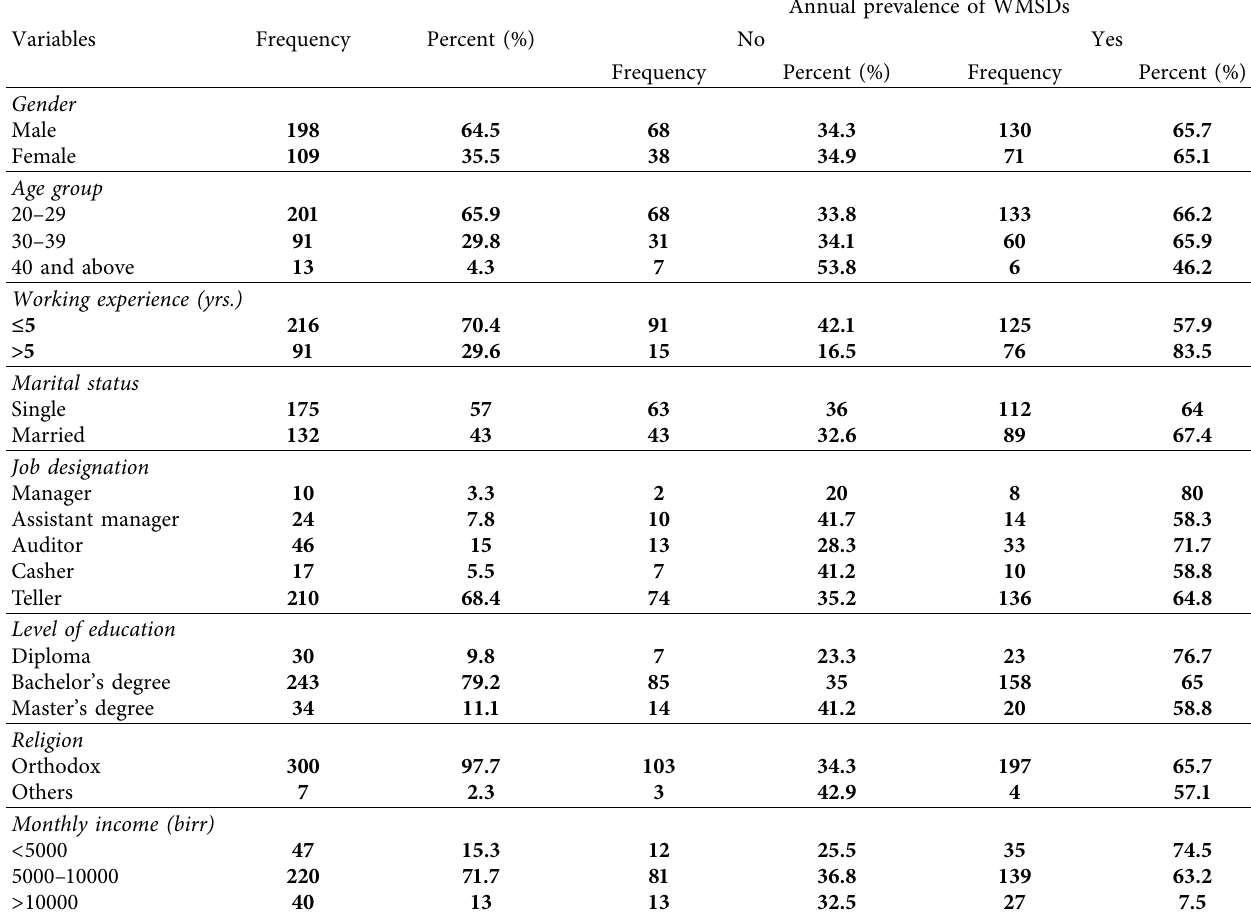
Table 1: Sociodemographic characteristics of bankers working in Mekelle city, Tigray, Ethiopia, 2018 ( n � 307).